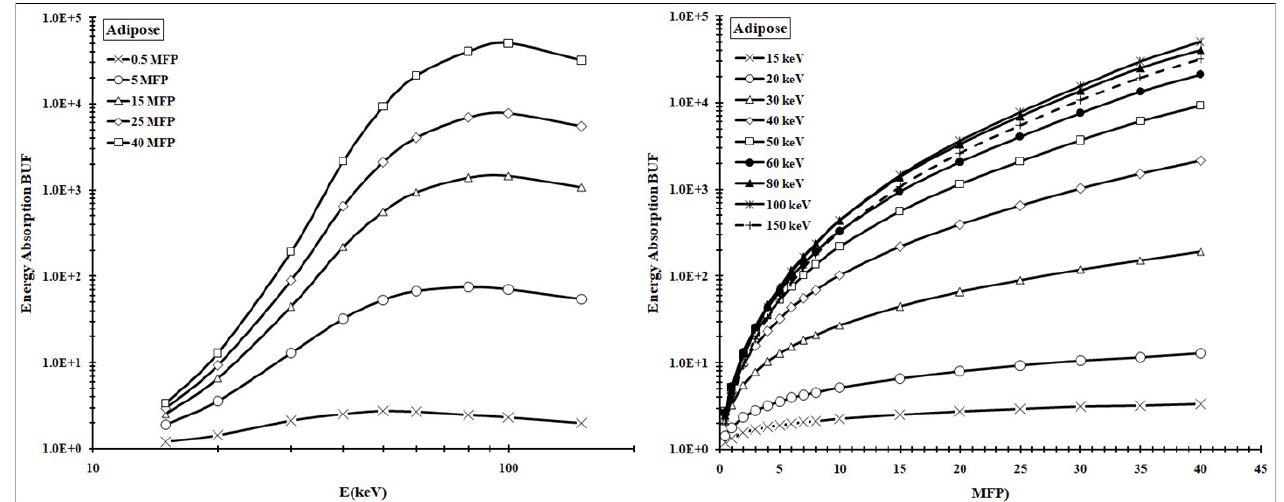
Figure 2. Energy absorption buildup factor for adipose tissue as a function of: ( left side) photon energy for fixed depths between 0.5 and 40 mfp and ( right side) depth for fixed photon energy between 15 and 150